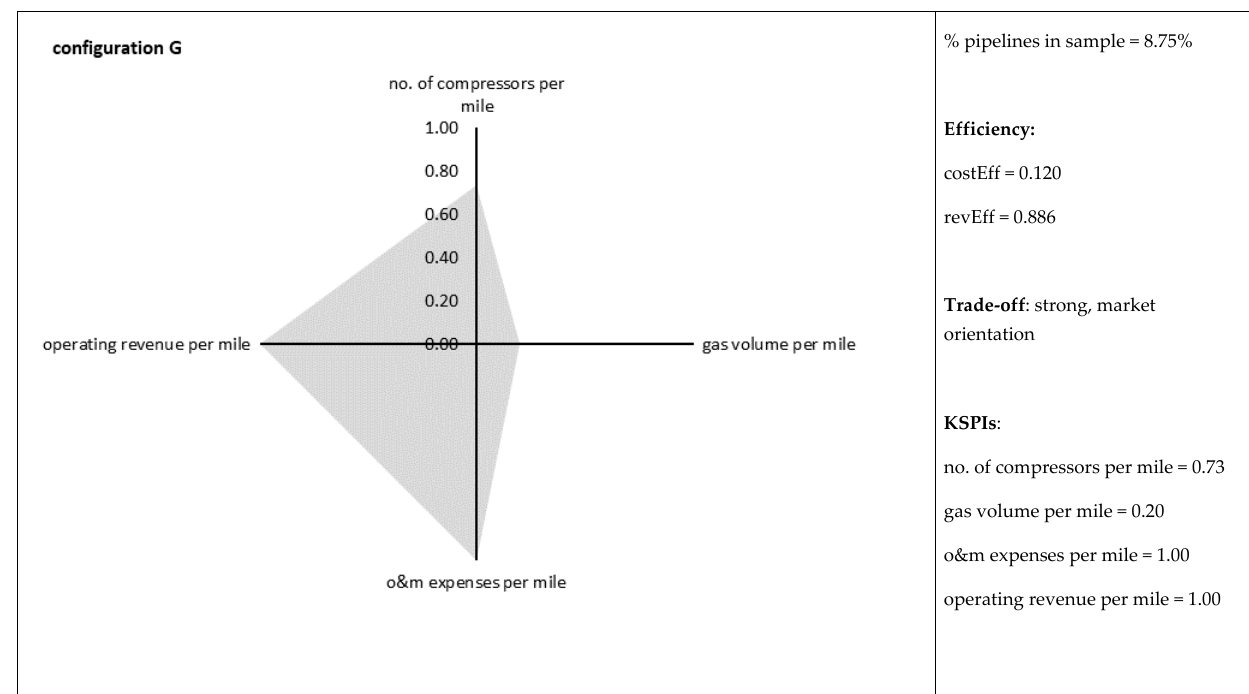
Figure A1. Comparison of gas transmission configurations. Figure A1. Cont